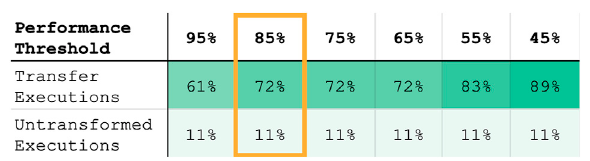
FIGURE 11 | Percentage of within-task transfer executions (selected by best- fi t model) and untransformed trajectories achieving various performance thresholds (de fi ned as the % of maximum performance metric for that task, described in Section 5.10 ). Our proposed models result in a higher percentage of transfer executions that complete the task to a high performance threshold (e.g., sweeping ≥ 85 % of the objects off the table). Furthermore, while the untransformed baseline produces all-or-nothing performance behavior, our models degrade gracefully, resulting in partial task completion (represented by lower % performance thresholds) even when the learned transform is non-optimal.